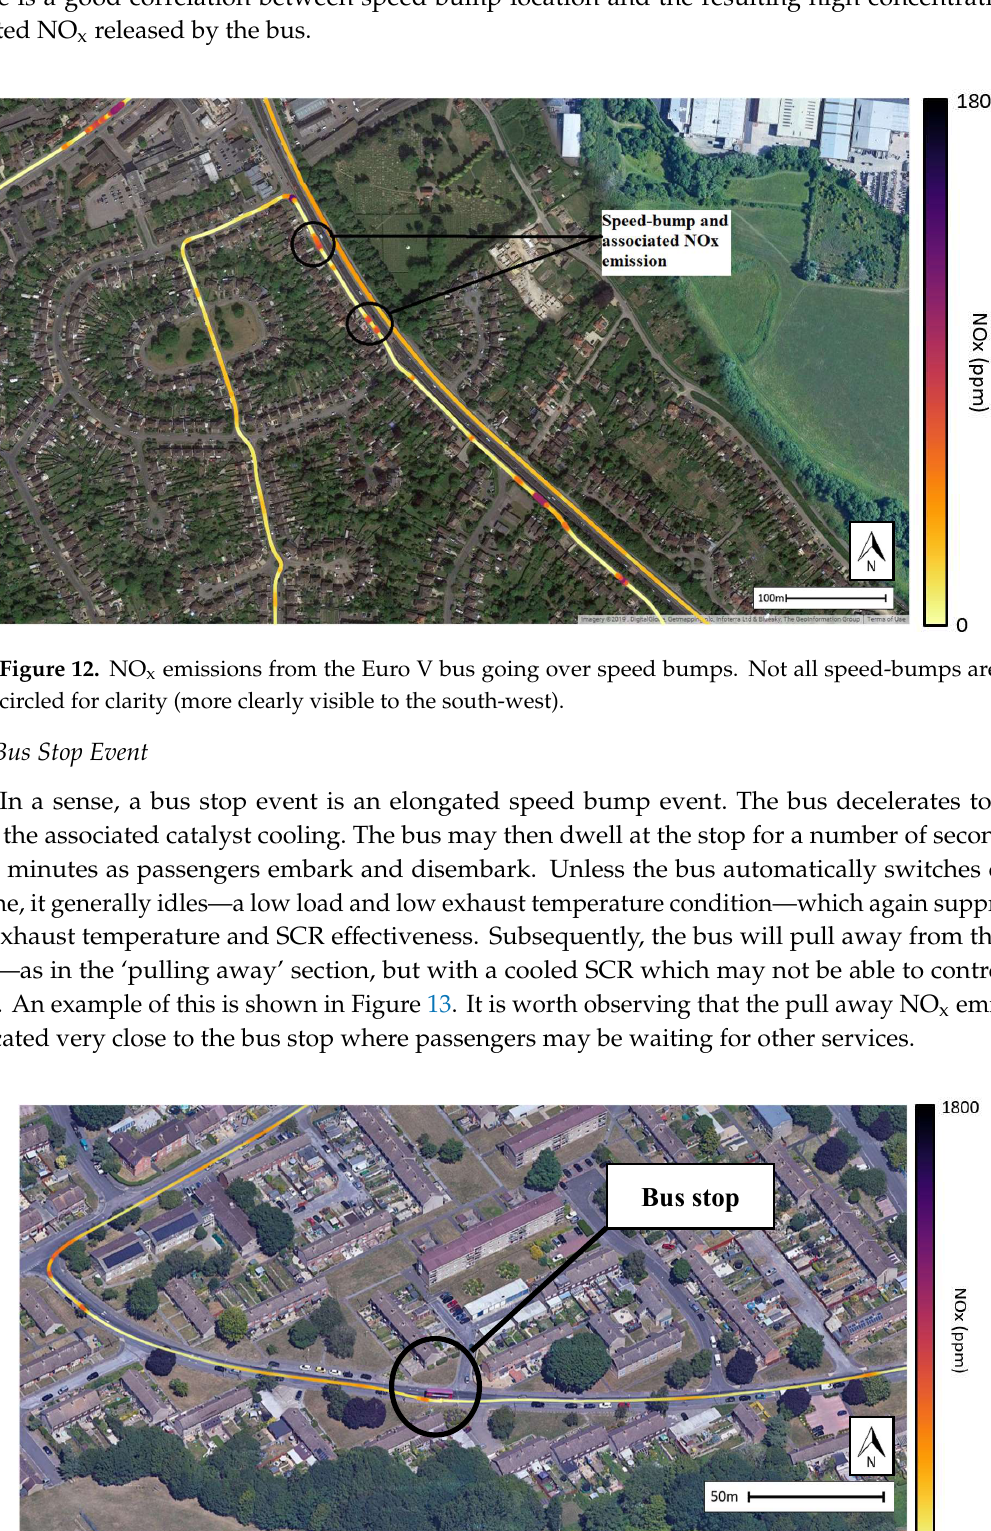
Figure 13. A bus stop event with the Euro VI bus.